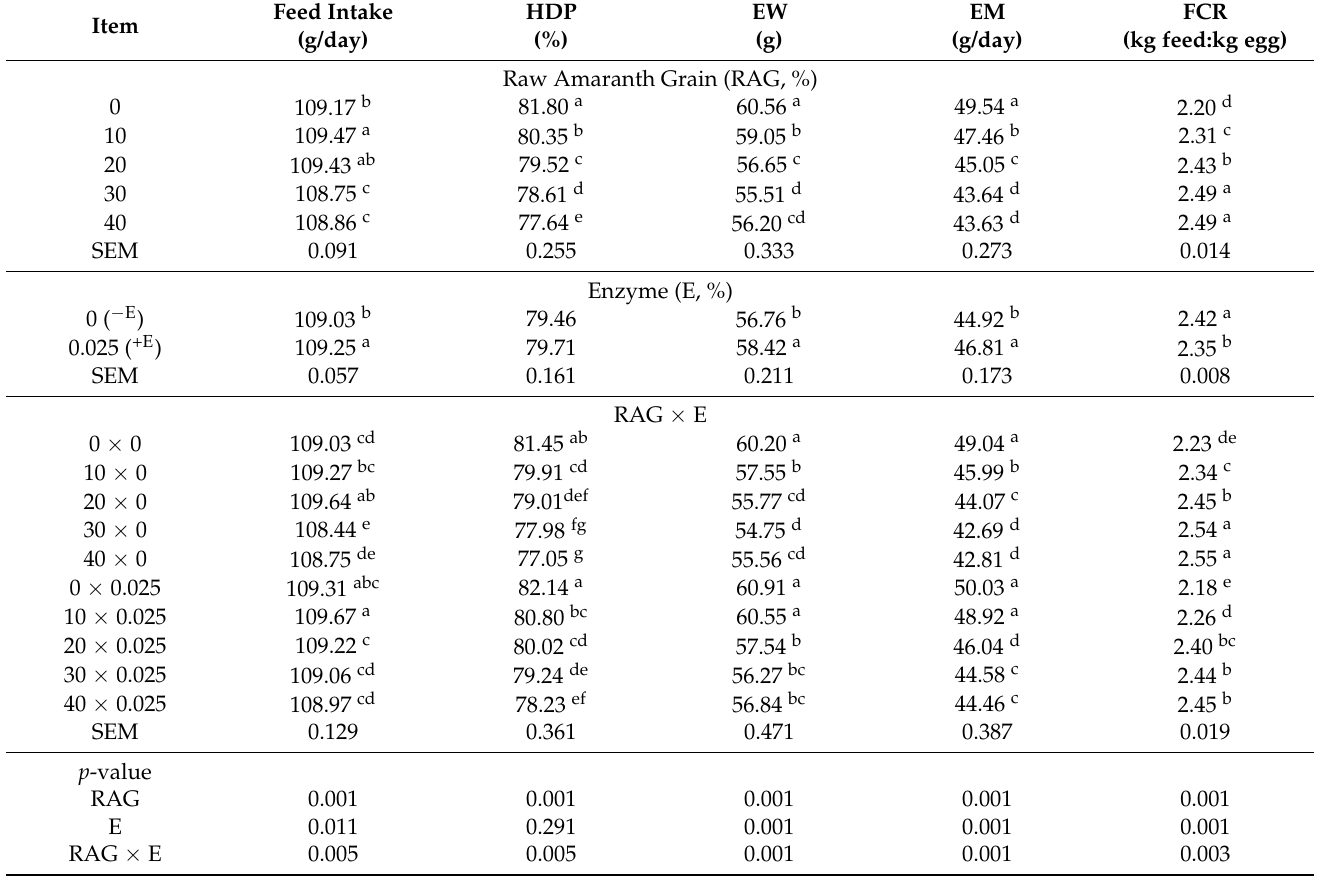
Table 4. Effect of experimental diets on productive performance of laying